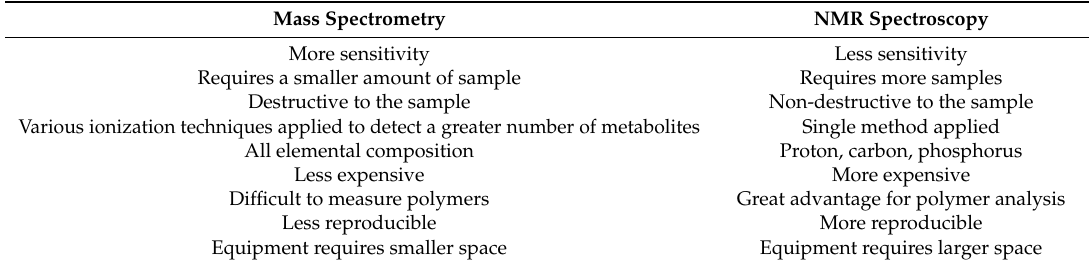
Table 1. Major advantages and disadvantages of the mass spectrometry (MS) and NMR